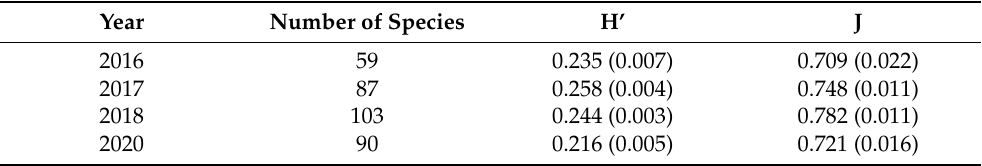
Table 5. Mean ( ± SE) annual variation of Shannon diversity (H’) and Pielou’s evenness (J) of plant species per 1 m 2 quadrat in Ruby Run, Preston County, West Virginia, USA. Surveys were conducted in September 2016, June and September 2017 and 2018, and July 2020. The number of plots varied between 63 in 2016 and 82 in 2020 ( n = 445 plots across 6 visits in 4